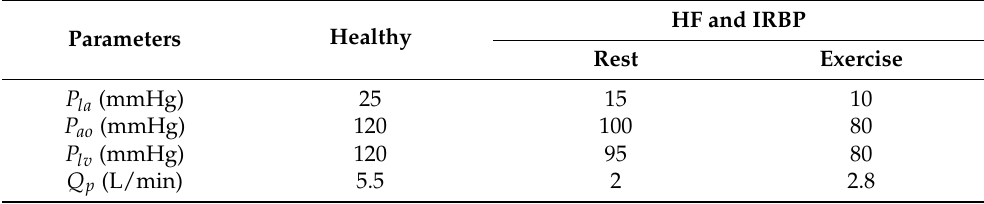
Table 4. CVS variables from the simulation